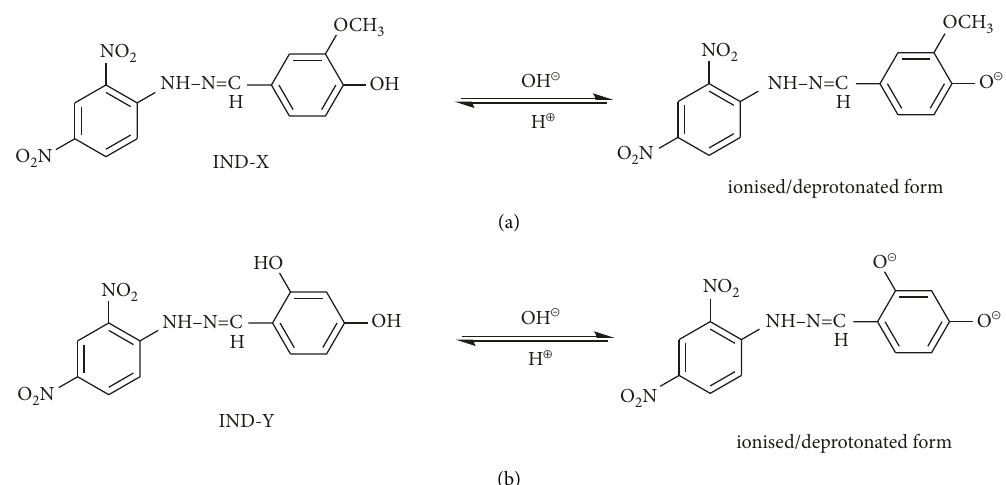
Figure 2: The ionisation of IND-X and IND-Y in an alkaline medium (bathochromic shift with pink colour). (a) UV-Vis spectrum of IND- X. (b) UV-Vis spectrum of